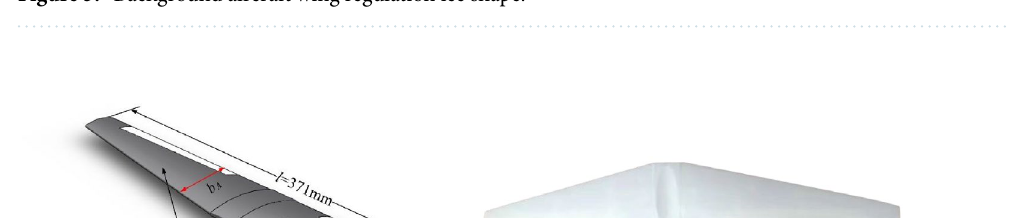
Figure 3. Background aircraft wing regulation ice shape.